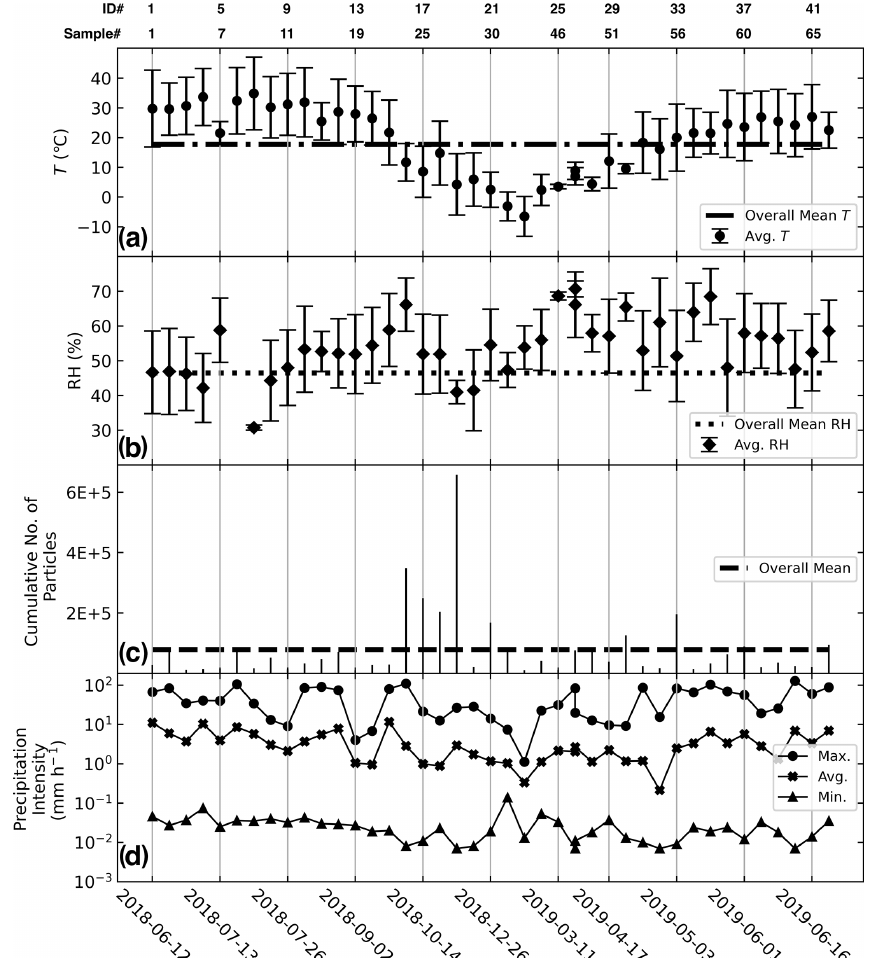
Figure 1. Time series of disdrometer and IoT sensor measurements for (a) average temperature ± SD (standard deviation); (b) average rela- tive humidity ± SD; (c) cumulative number of detected hydrometeors in each precipitation event; and (d) maximum, average, and minimum precipitation intensity. Each data point corresponds to the sampling start time for each precipitation